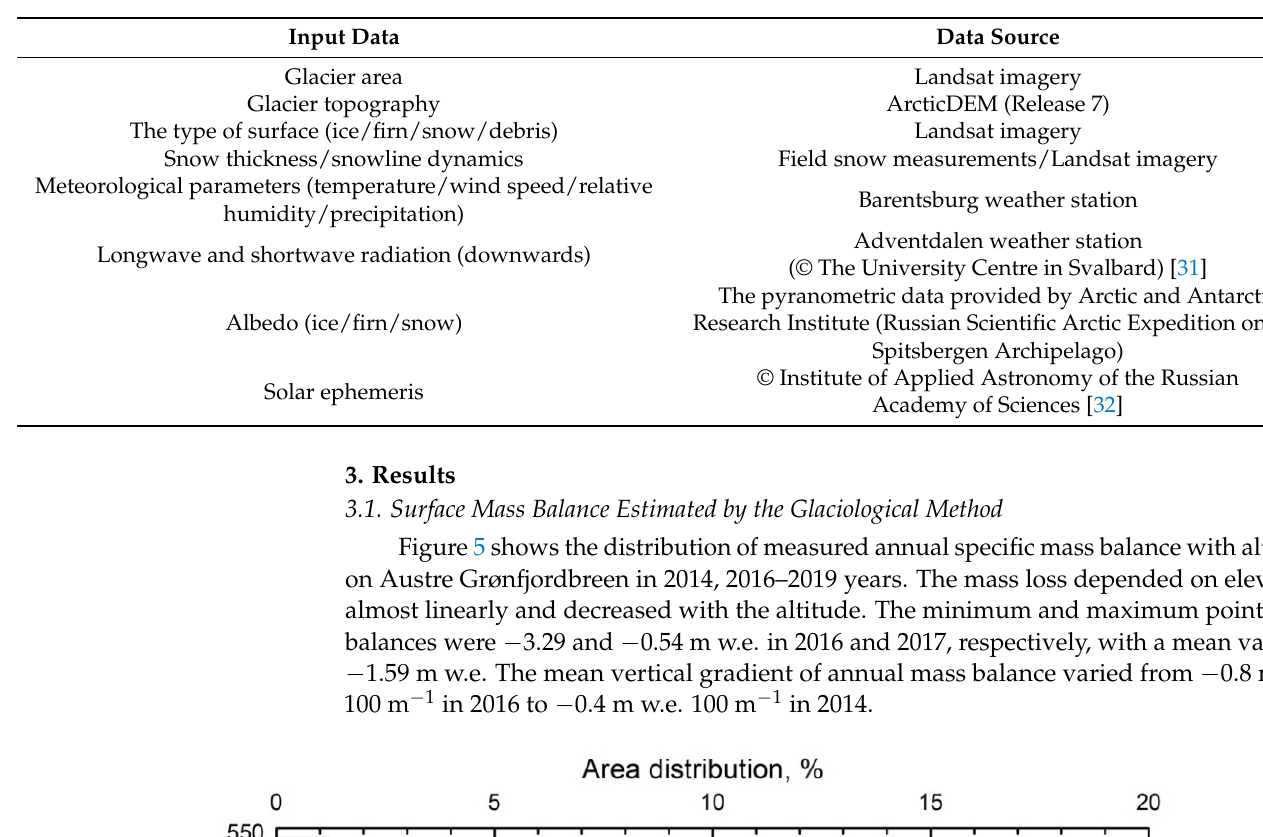
Table 3. The input data used for mass-balance modeling.